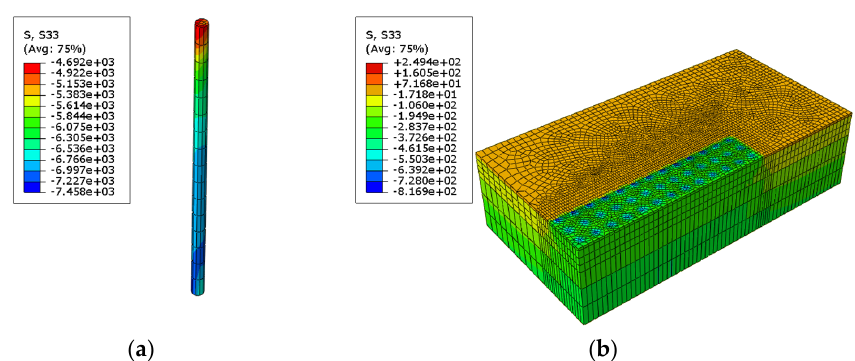
Figure 17. Vertical stress contour (kPa): ( a ) rigid pile; and ( b ) soil.